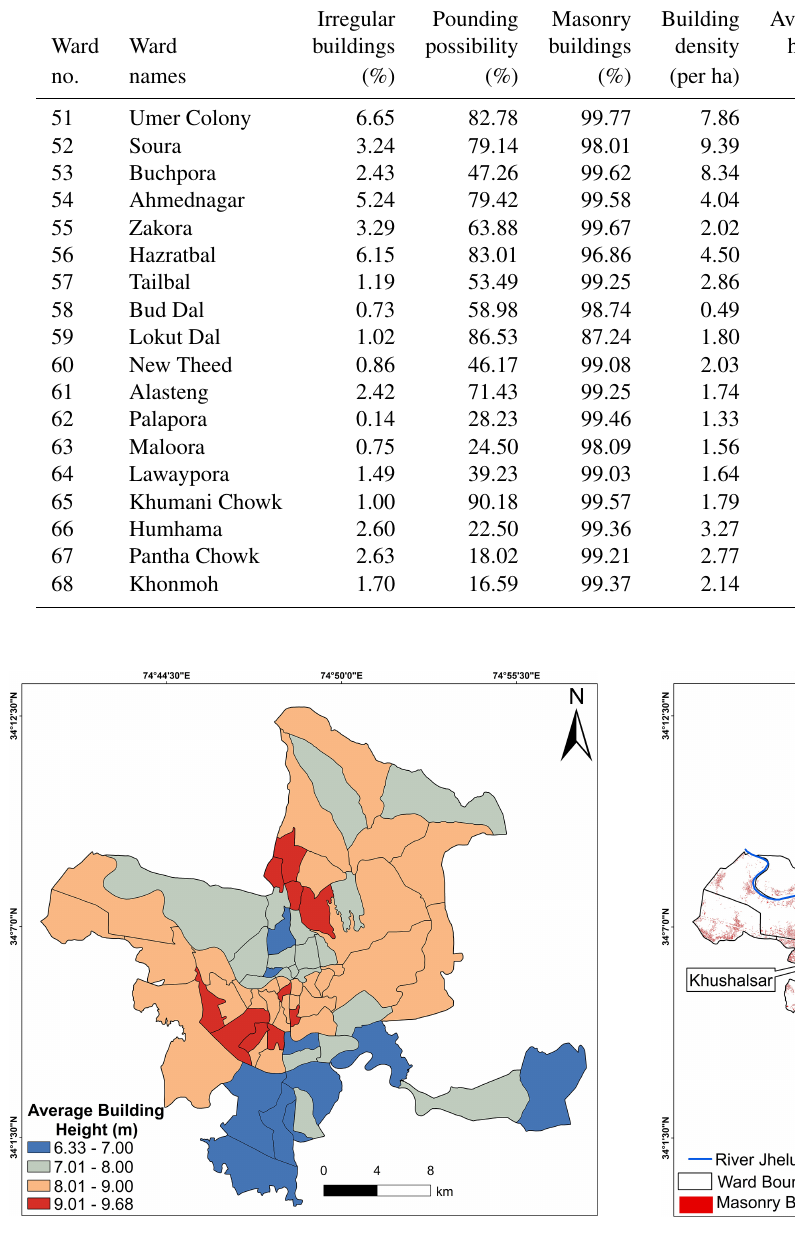
Figure 4. Ward-wise distribution of average building height in Sri- nagar.